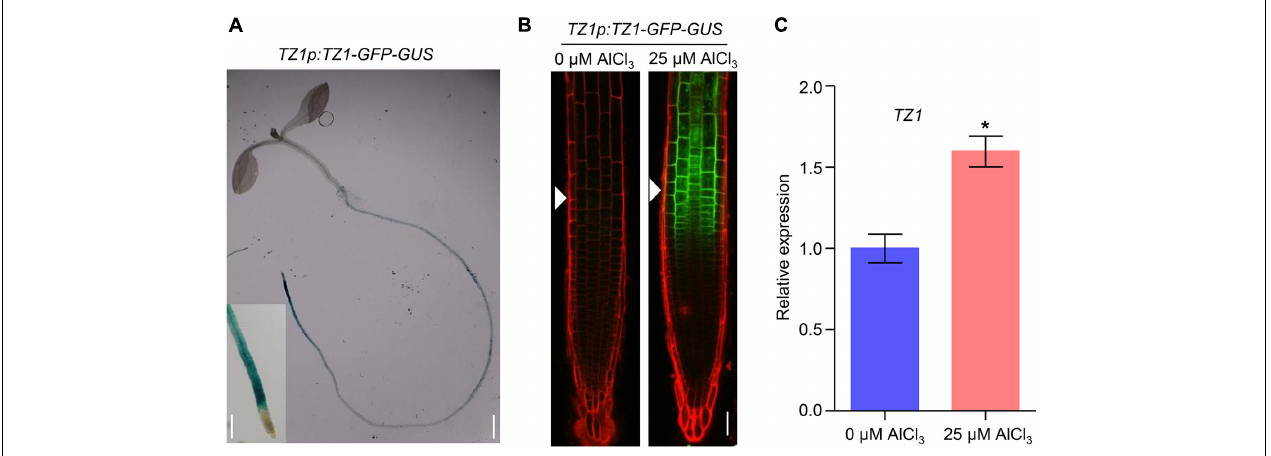
FIGURE 2 | Aluminum stress-induced expression of TZ1 in the transition zone. (A) The β -glucuronidase (GUS) staining of TZ1p:TZ1-GFP-GUS showed that TZ1 is expressed in the Arabidopsis root, with the high expression in the transition zone (TZ), elongation zone (EZ), and mature zone (MZ). Left scale bar, 50 µ m. Right scale bar, 1 cm. (B) 7-day-old TZ1p:TZ1-GFP-GUS seedlings were exposed to 0 or 25 µ M AlCl 3 for 3 h. Cell boundaries appear red following propidium iodide (PI) staining. The root TZ is marked with white arrowheads. Scale bar, 100 µ m. (C) Relative expression of TZ1 by qRT-PCR assay in the 7-day-old WT Arabidopsis roots treated with 0 or 25 µ M AlCl 3 for 3 h. UBQ1 was used as the reference. Values are given as mean ± SD ( n = 3). * p < 0.05 (Student’s t -test).